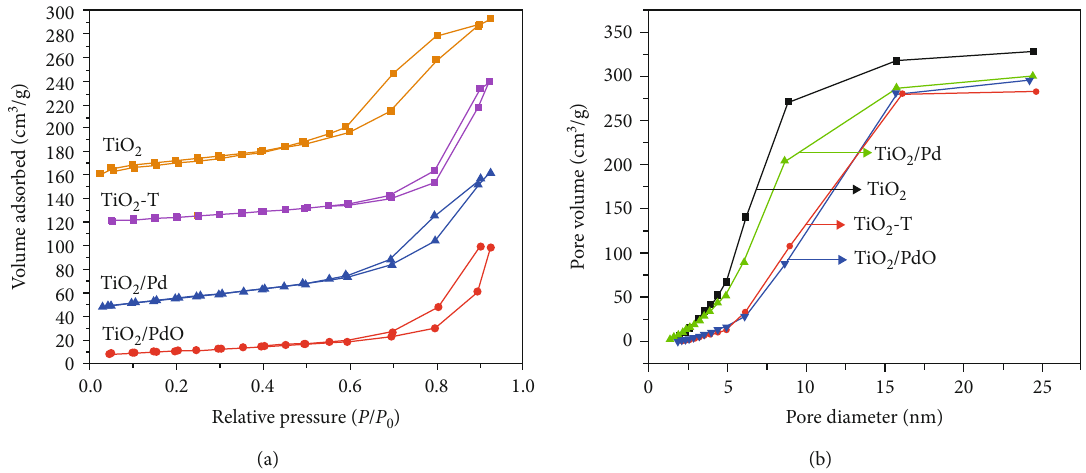
adsorption-desorption isotherms and (b) pore size distribution of TiO 2 , TiO -T, TiO /Pd, and TiO 2 2 2